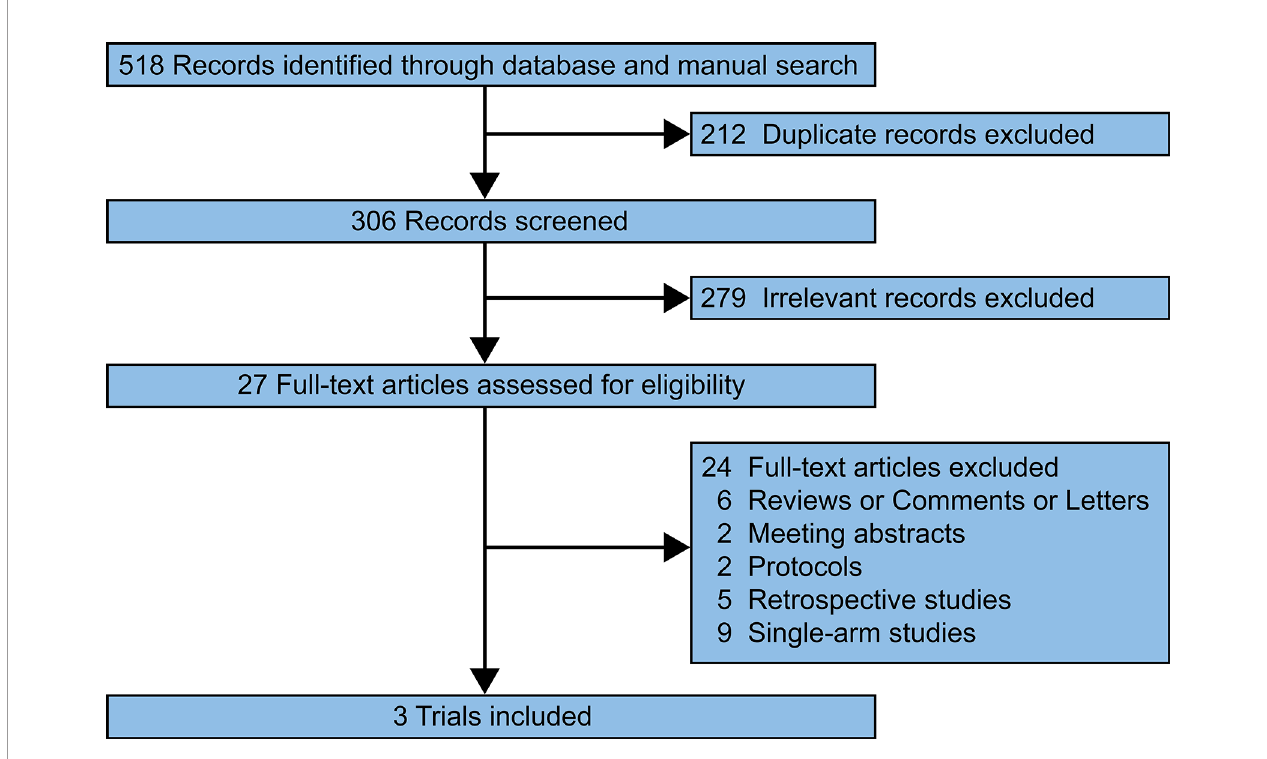
FIGURE 1 | Flowchart of the selection